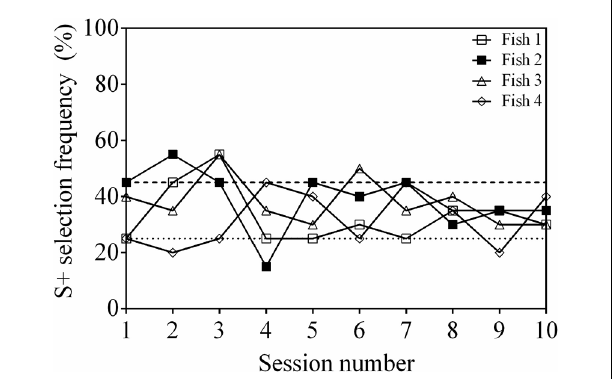
FIGURE 2 | Discrimination performance as a function of time (binned by testing session), for four fish performing an odd-one-out task. Two stimuli were selected for each trial from a pool of four possibilities. See Table 1 for stimuli used.The dashed line at 45% indicates a statistically significant selection frequency of S + and the dashed line at 25% indicates